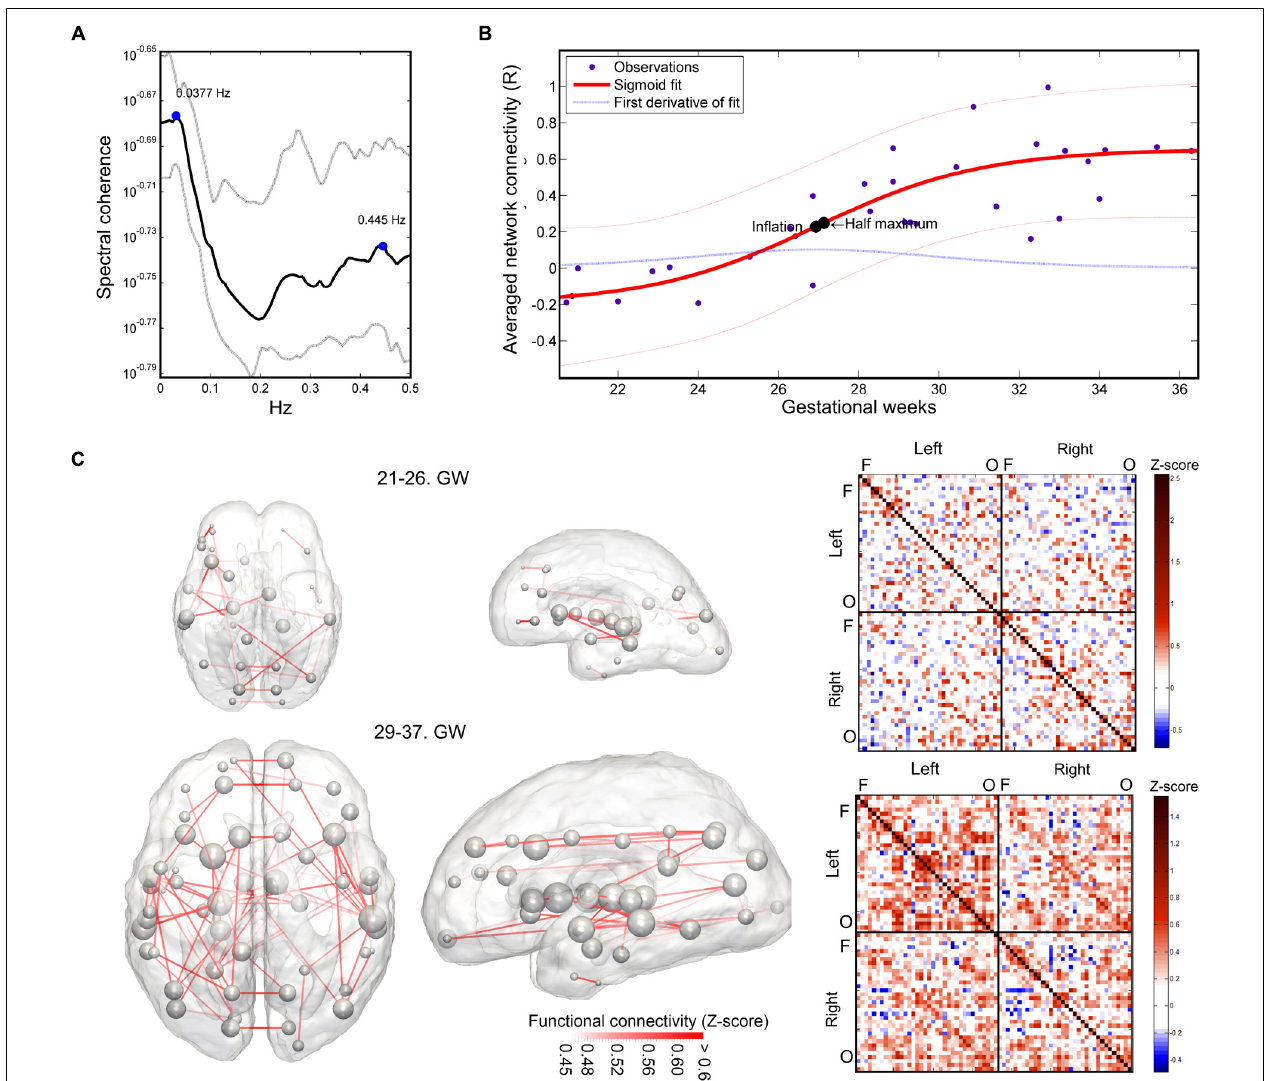
point of the curve is found at the 27th GW and it depicts the gestational age in which the maximum increase of intrinsic functional connectivity is found. (C) Developmental expansion of the fetal functional brain connectome, visualization as matrices and 3D graphs.Two stages of the development are depicted: prior to the presumed expansion of functional connectivities (21st–26th GWs) and after this period.This dichotomy was defined using the average intrinsic functional connectivity values (B) .The transparence of each edge in the 3D visualization (left images) refers to the population mean of the intrinsic functional connectivity ( Z -score).The size of nodes in the network depiction is proportional to the sum of connectivity values over all edges that are connected to them. Group-mean network edges were visualized using a threshold of Z = 0.45. Graphs were overlaid on anatomical templates from the 23rd and 37th GWs.The mean connectivity networks are also visualized as connectivity matrices, Fs, frontal regions, Os, occipital regions.